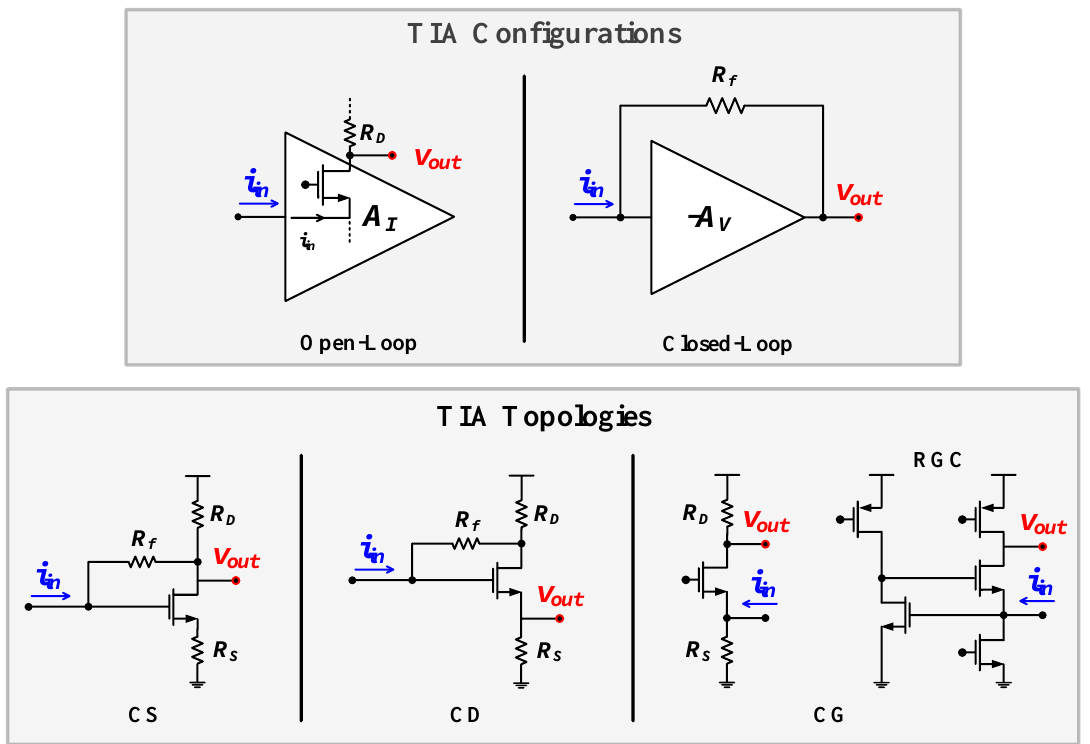
Figure 5. Different TIA configurations and